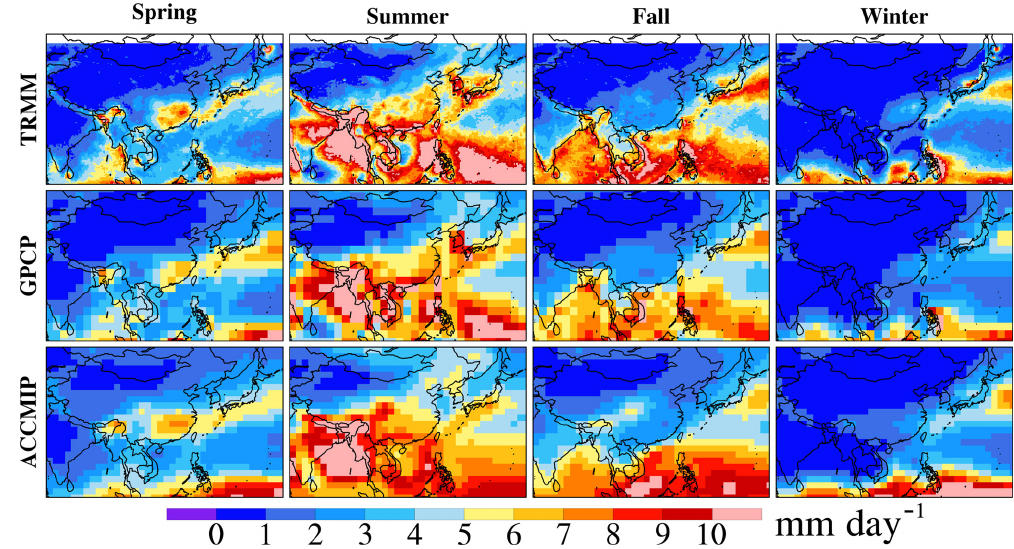
Figure 1. Evaluation of seasonal mean precipitation during 2001–2010: ACCMIP multi-model ensemble mean vs. TRMM and